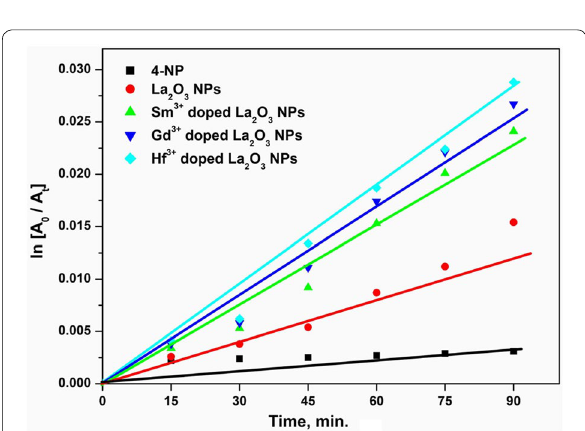
Fig. 8 Linear plots of ln(A 0 /A t ) vs. time for catalytic reduction of 4-nitrophenol over the synthesized undoped and doped La 2 O 3 NPs